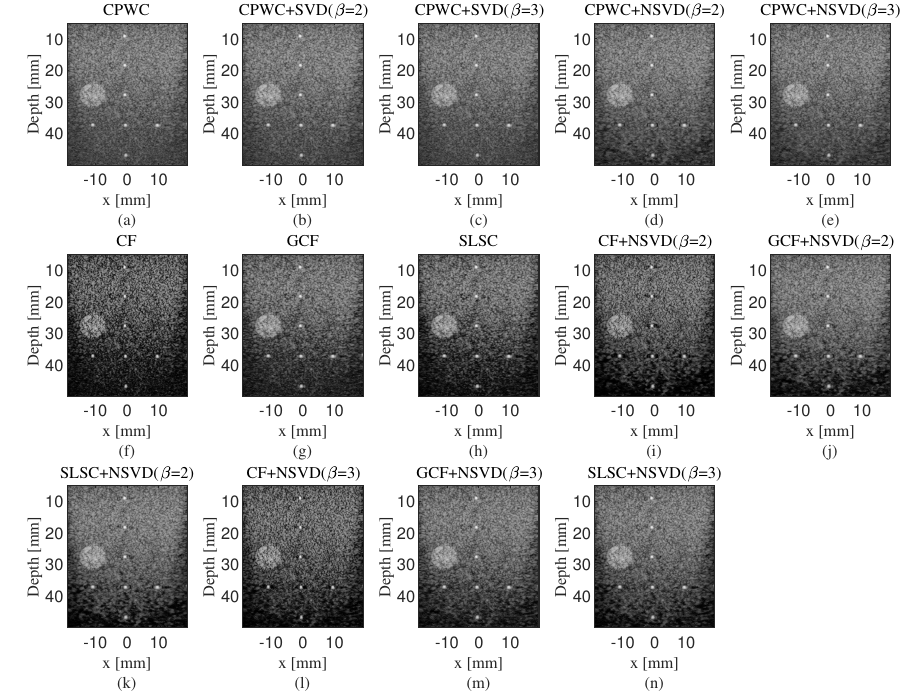
Figure 8. B-mode images of experimental phantom with point targets formed by different methods. ( a ) CPWC, ( b ) CPWC+SVD ( β = 2), ( c ) CPWC+SVD ( β = 3), ( d ) CPWC+NSVD ( β = 2), ( e ) CPWC+NSVD ( β = 3), ( f ) CF, ( g ) GCF, ( h ) SLSC, ( i ) CF+NSVD ( β = 2), ( j ) GCF+NSVD ( β = 2), ( k ) SLSC+NSVD ( β = 2), ( I ) CF+NSVD ( β = 3), ( m ) GCF+NSVD ( β = 3), ( n ) SLSC+NSVD ( β = 3).